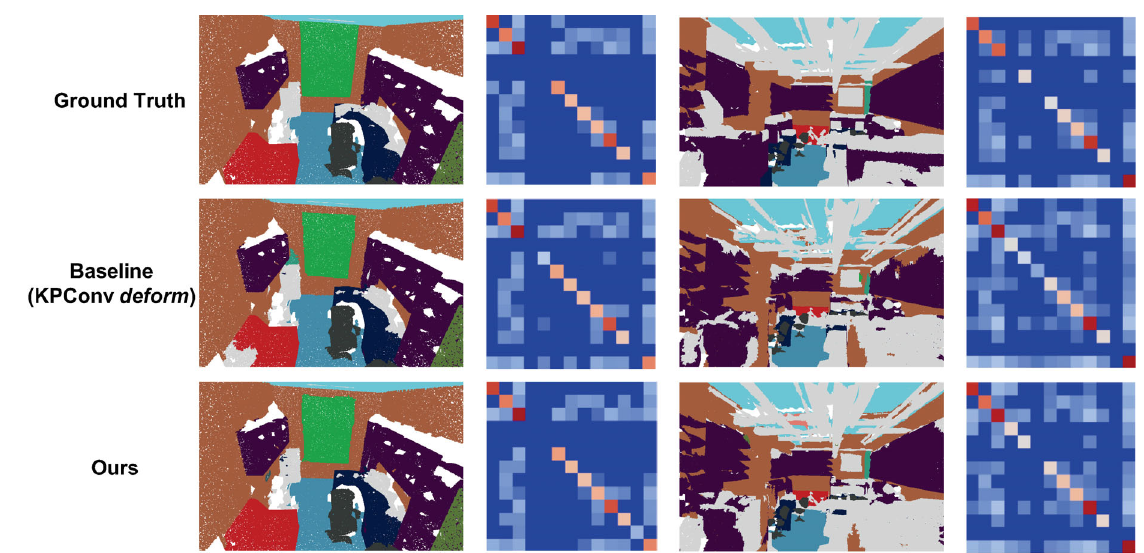
Fig. 5 Visualization results of NCM for scenes in